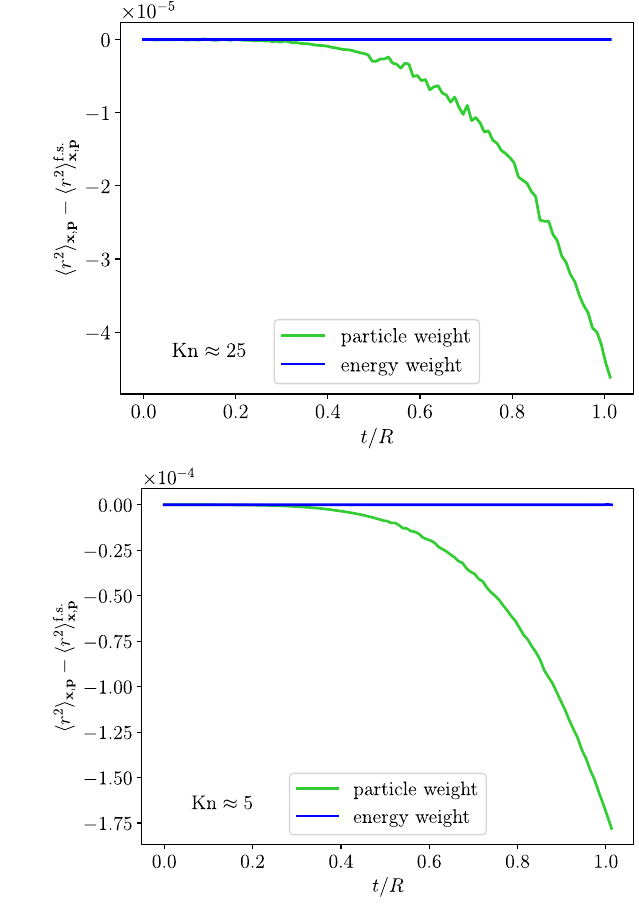
Fig. 10 Time evolution of the departure of (cid:3) r 2 (cid:4) x , p with particle- number (green) or energy (blue) weighting from its free streaming behavior, for simulations with Kn ≈ 25 (top panel) or Kn ≈ 5 (bottom panel)